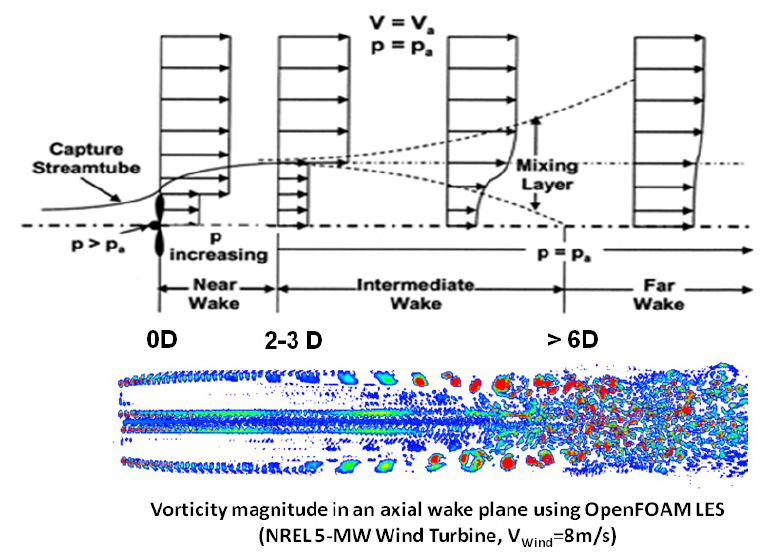
Figure 1. The Wake of a Wind Turbine (D = Turbine Rotor